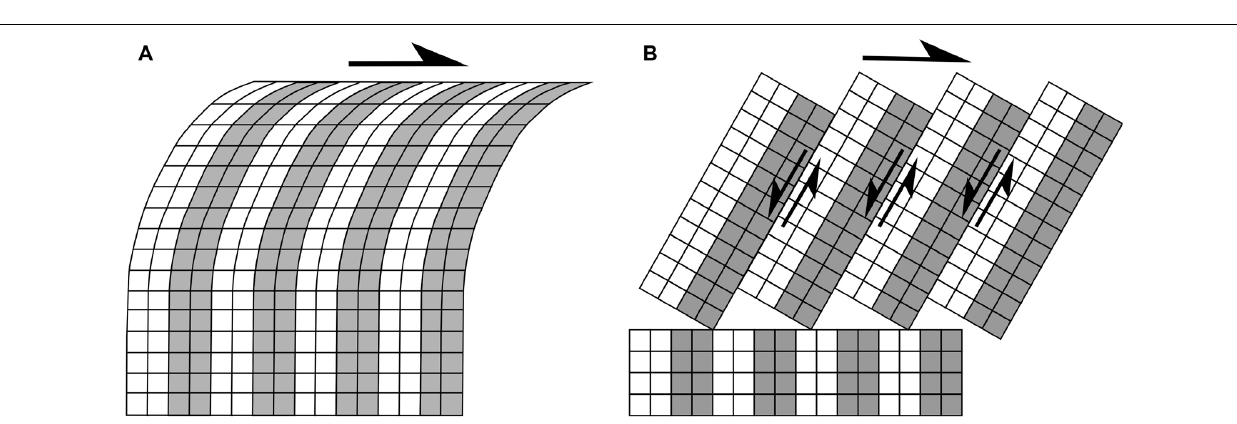
FIGURE 10 | (A) Plot of extension fractures and faults located exclusively along the prolongation of the Husavik-Flatey Fault (HFF) and having a different strike from the remaining structures of the ThFS, (B) analog model of shallow, right-lateral normal faults above a transtensional right-lateral wrench fault. Note the similarity with (A) . Redrawn after Tibaldi et al. (2016b).